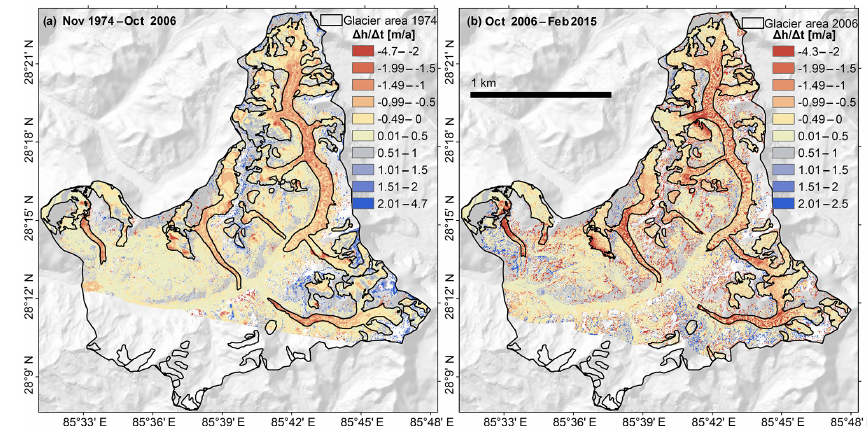
Figure 4. Elevation change rates ( (cid:49)h/(cid:49)t ) derived from (a) Hexagon November 1974 and Cartosat-1 October 2006 DEMs and (b) Cartosat- 1 October 2006 and WorldView February 2015